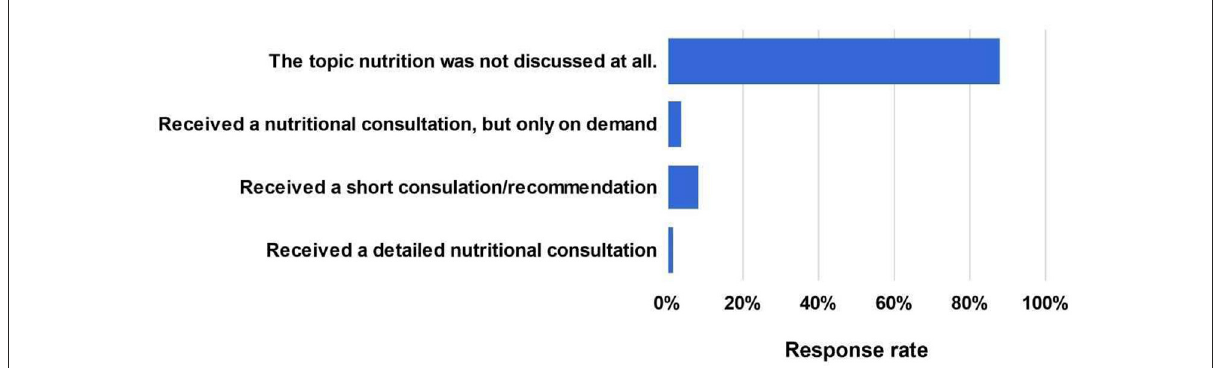
FIGURE2 Responses to the question of whether participants received nutritional consultations from their dermatologists.